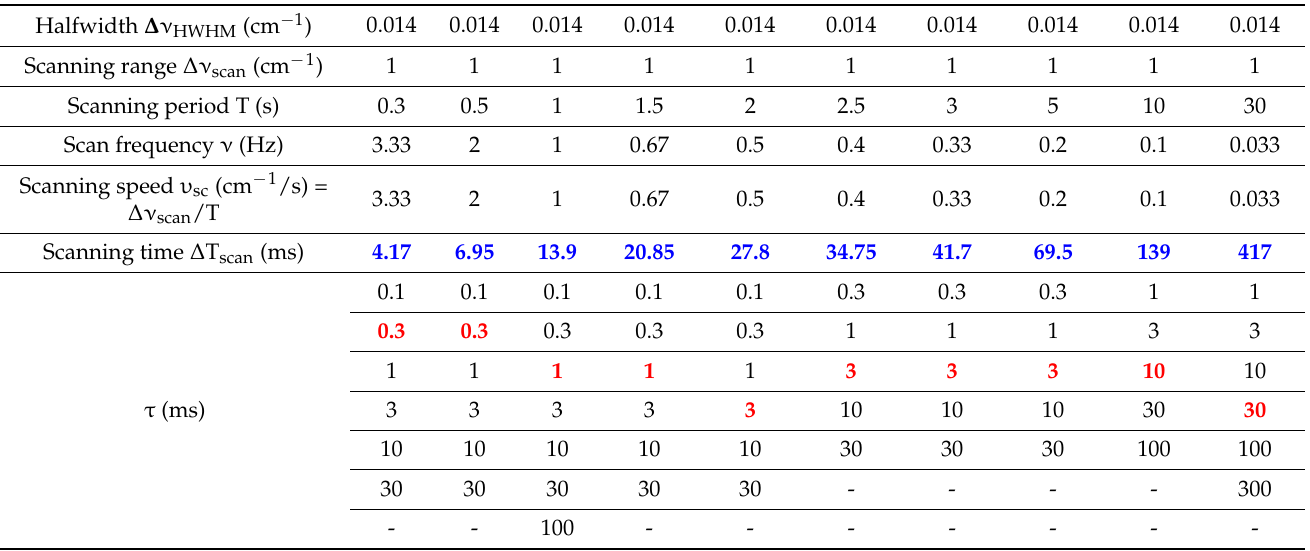
Table 1. Simulation of LP filter effect on absorption line shape with different τ . HWHM: Half Width at Half